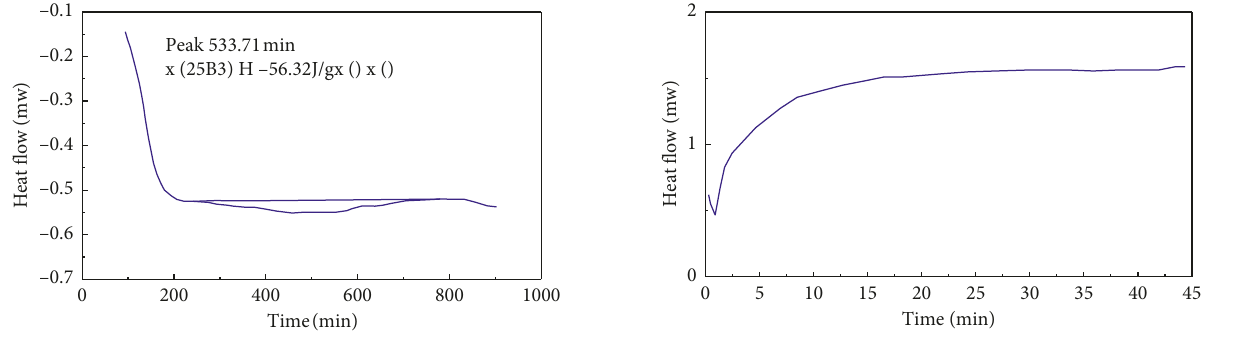
Figure 4: Cement protoplasmic DSC curve under the condition of 25 ° C.